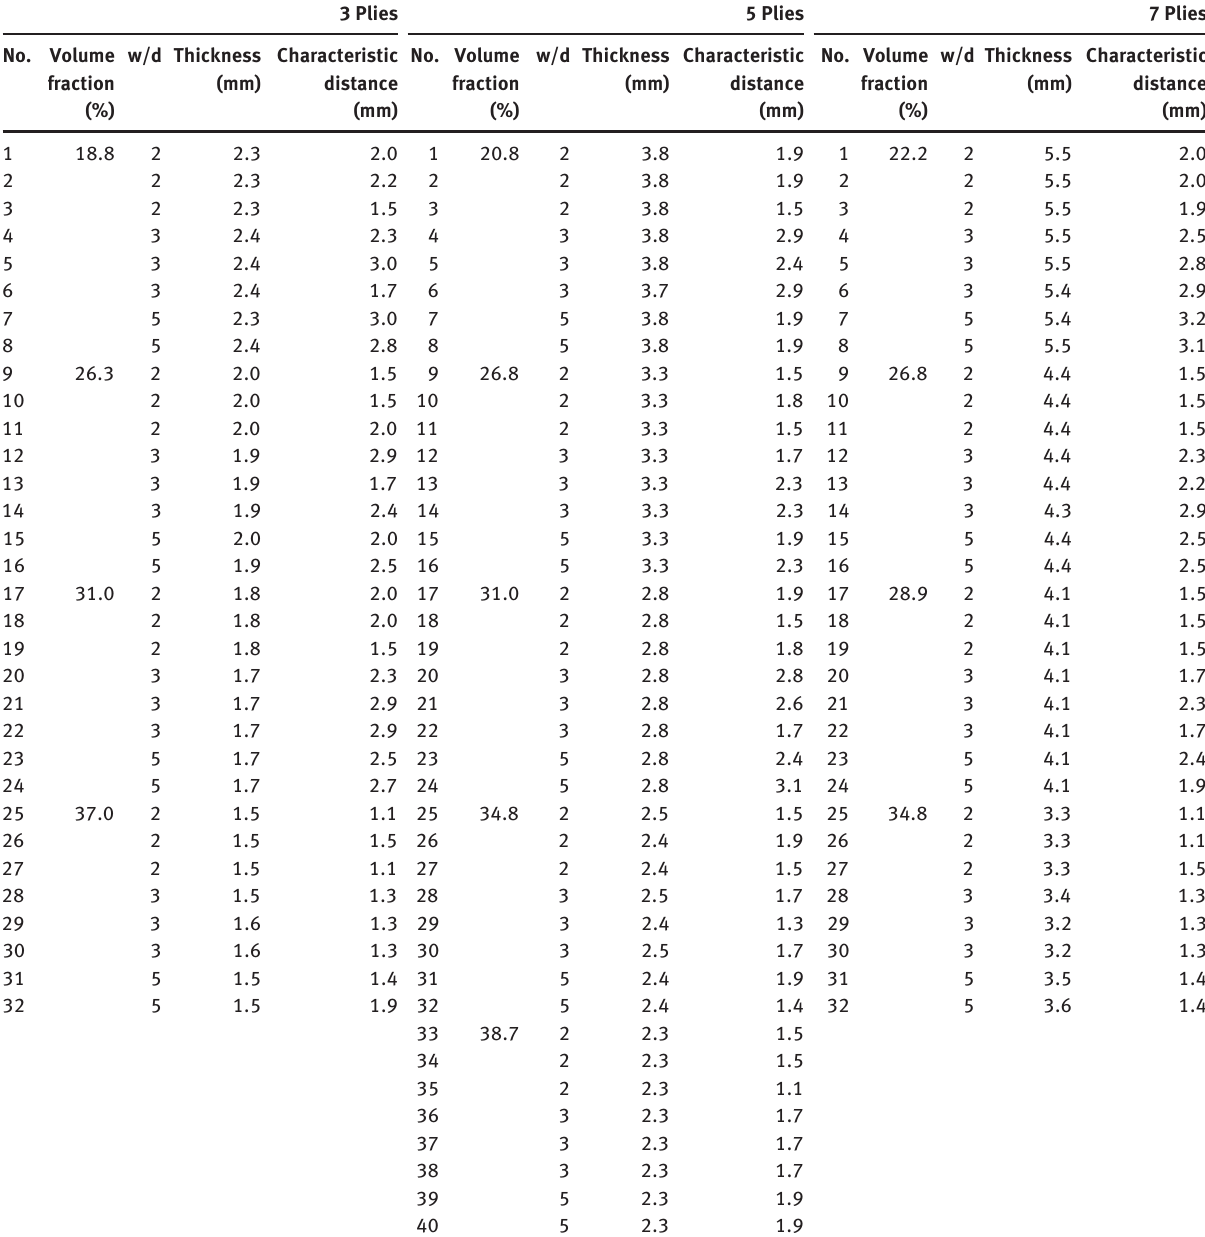
Table 2 Calculation results of characteristic distance ( d